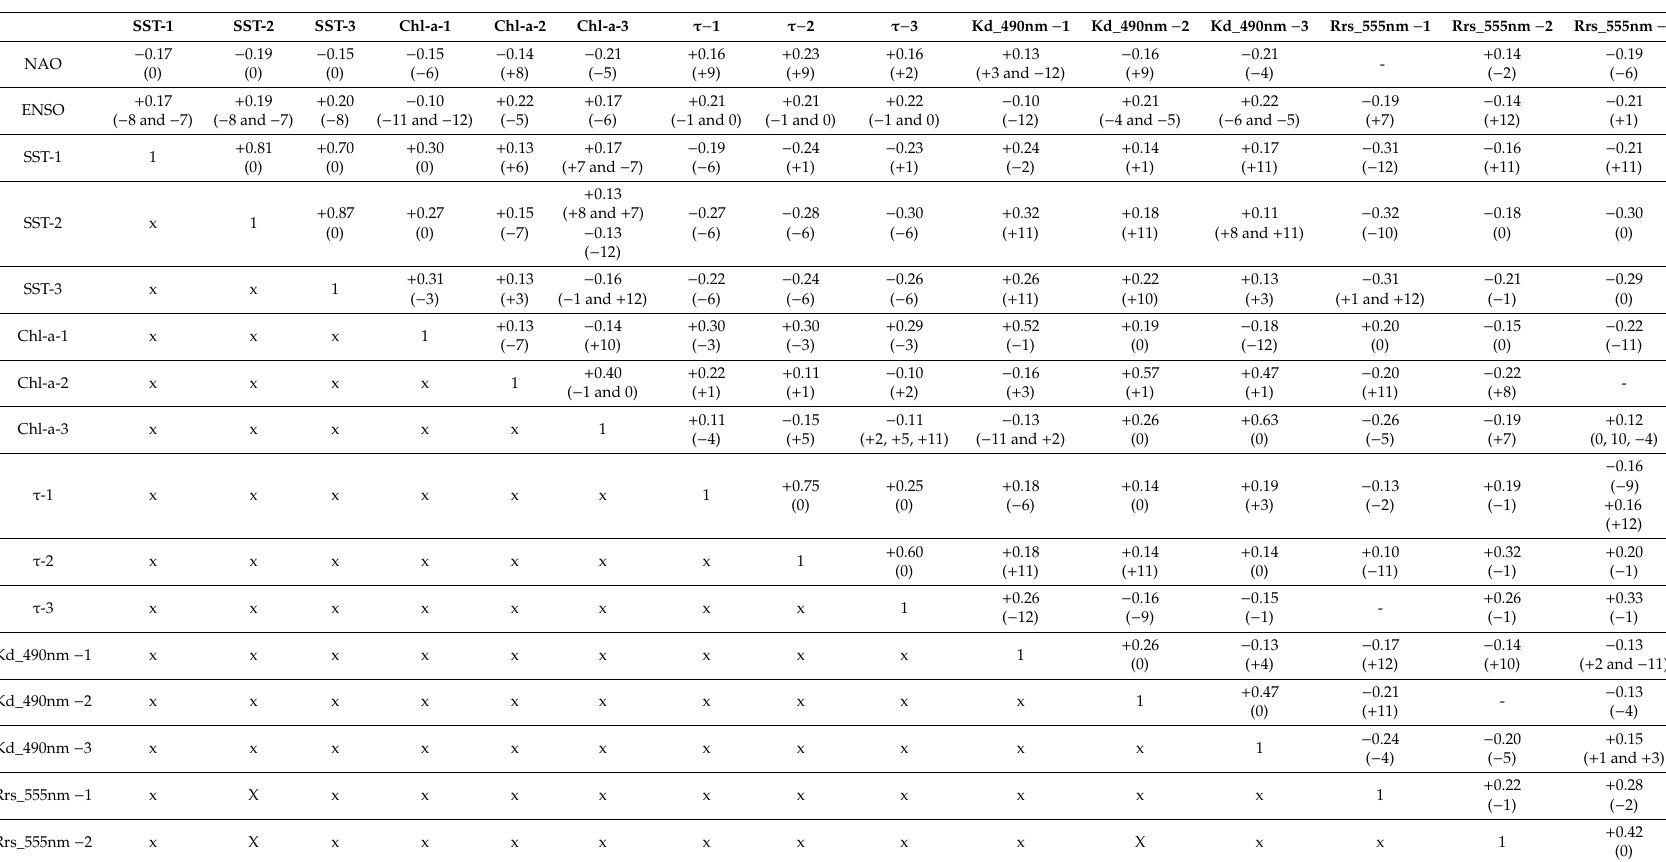
Table 1. Correlation coe ffi cient and time lags of maximum correlations (in parentheses) for the North Atlantic Oscillation (NAO), El Nino-southern oscillation (ENSO), and sea surface temperature (SST) anomalies (SST-1, SST-2 and SST-3), Chl-a concentration (Ch-1, Ch-2 and Ch-3), wind stress ( τ -1, τ -2, and τ -3), attenuation coe ffi